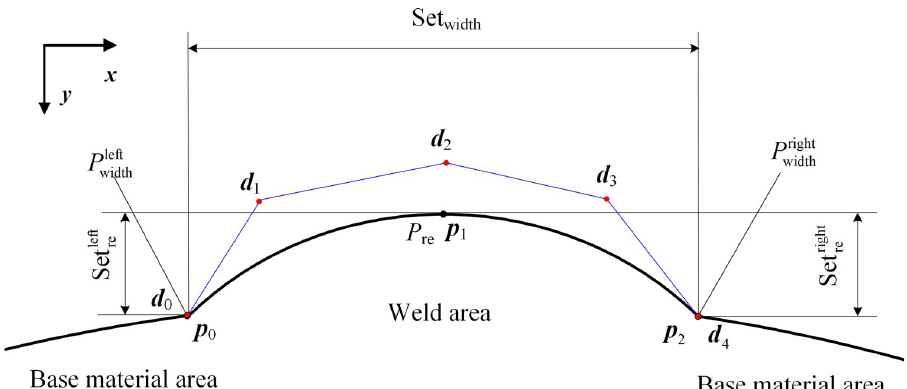
Fig 9. Simulation of normal weld curve.